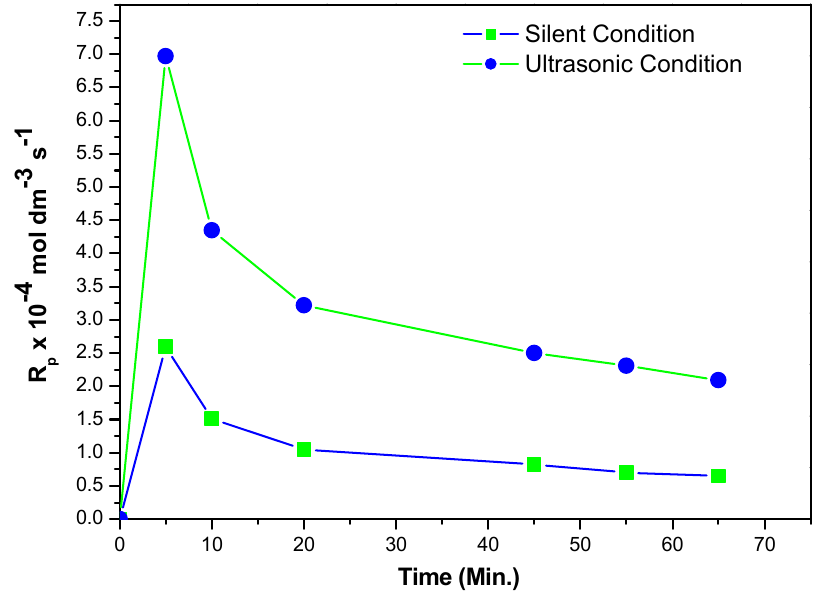
Figure 1. A plot of R vs. time, indicating steady-state rate of polymerization of MABE: p 2.00 × 10 − 2 mol·dm − 3 of PPS, 1.2 × 10 − 2 mol·dm − 3 of BPMACB, 3.0 mol·dm − 3 of MABE, 0.3 mol·dm − 3 of [H + ], 0.1 mol·dm − 3 of [µ], 60 °C of temperature (50 kHz, 300 W